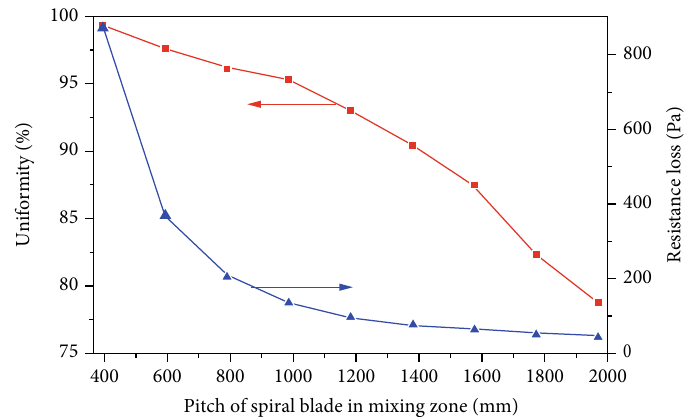
Figure 8: In fl uence of blade pitch on fl ow parameters in mixing